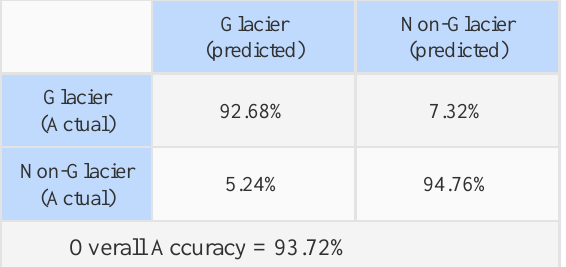
Table 2. Random Forest classification of glacier and non-glacier area